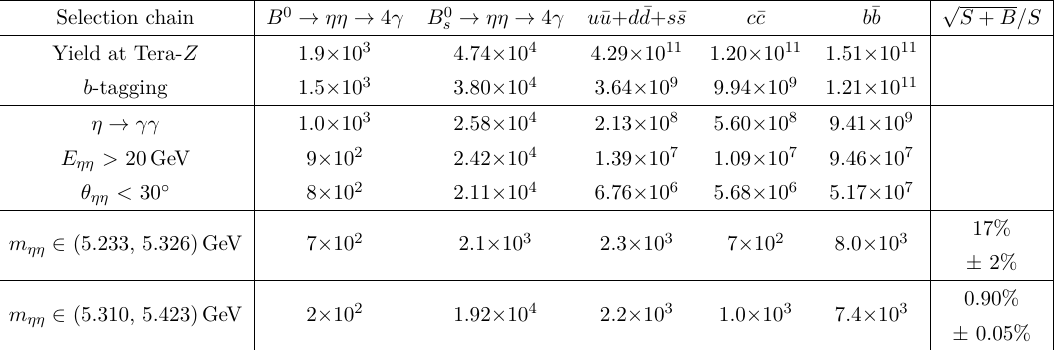
Table 5 . B 0 → ηη and B 0 √ ( S + B/S ) when using the baseline b -tagging and ECAL energy resolution of 3% √ last two rows, selections on m B 0 → ηη s